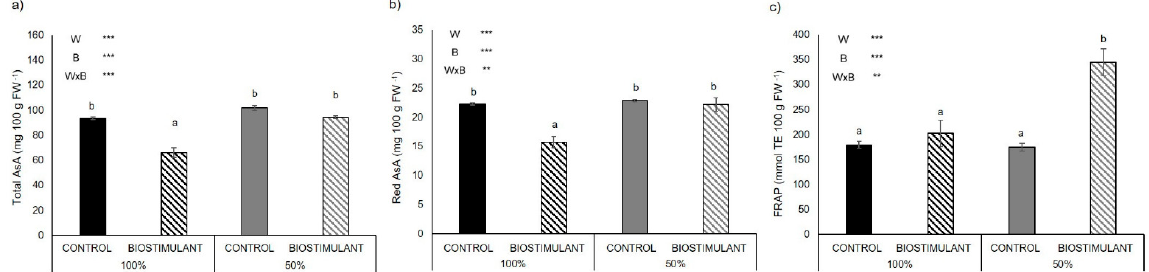
Figure 3. Total ( a ) and reduced (Red) ( b ) ascorbic acid (AsA) content and total antioxidant activity (FRAP) ( c ) in leaves of tomato genotype ‘E42’ grown in open field in Battipaglia under optimal (100% irrigation) and limited water availability (50% irrigation) and treated (biostimulant) or not (control) with the biostimulant. Values are mean ± SE. Asterisks indicate significant effect of limited water availability (W), biostimulant treatment (B) and their interaction (W × B) according to ANOVA (ns = not significant; * = p < 0.05; ** = p < 0.01; *** = p < 0.001). Different letters indicate significant differences based on Duncan’s test ( p ≤ 0.05).